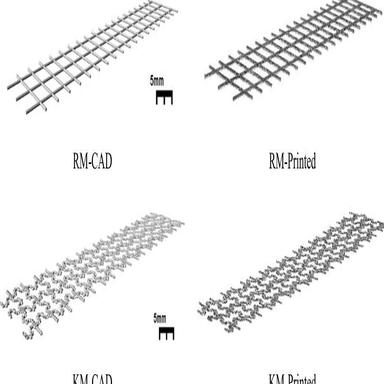
CAD models and 3D printed samples of a rectangular mesh (RM) and a Koch mesh (KM).